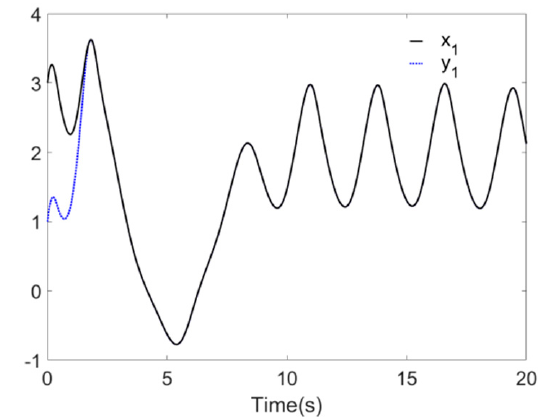
Figure 4. Synchronization process of y 1 arrives x 1